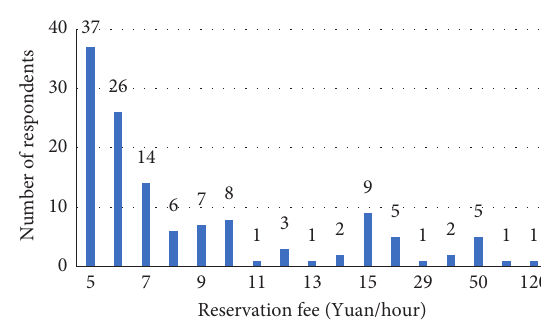
Figure 6: Ideal reservation fee.